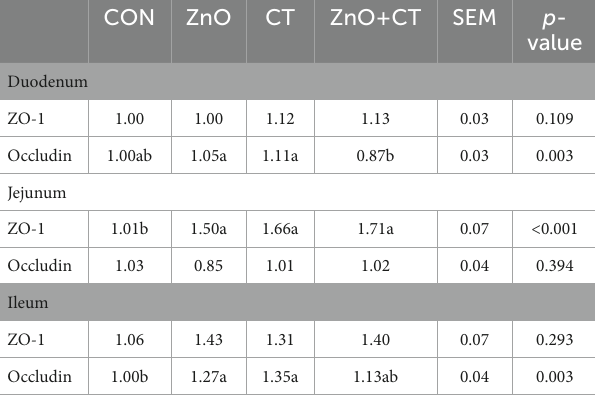
TABLE 4 Effects of ZnO and CT on intestinal tight junction gene expression in weaned piglets under K88-challenged environment.